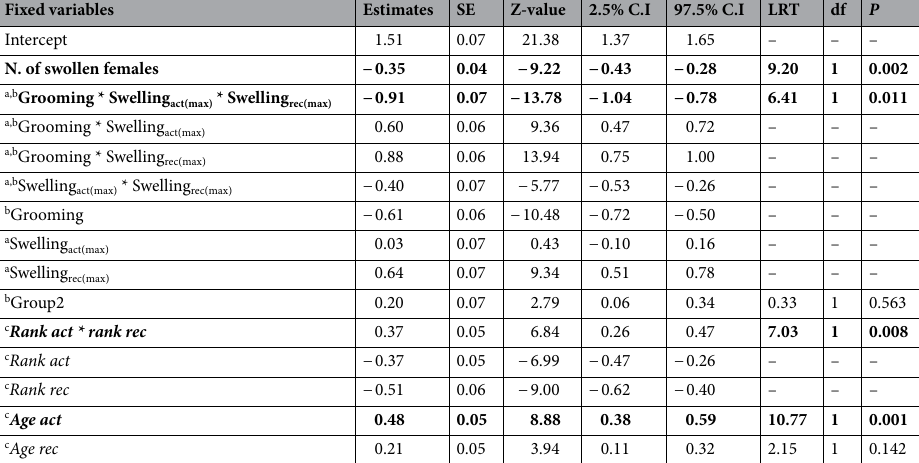
Table 2. Variables in Model 2 explaining the occurrence of daily GGR while controlling for rank and age of both actor and receiver. LTR likelihood-ratio test. Control variables are in italics, variables with significant P values are in bold and marked with *. Grooming = daily dyadic grooming preference. Swelling act,rec = sexual swelling condition of actor or receiver. a Dummy coded with “min” swelling condition as reference category. b Dummy coded with Group1 as reference category. c z-transformed to a mean of 0 and a standard deviation of